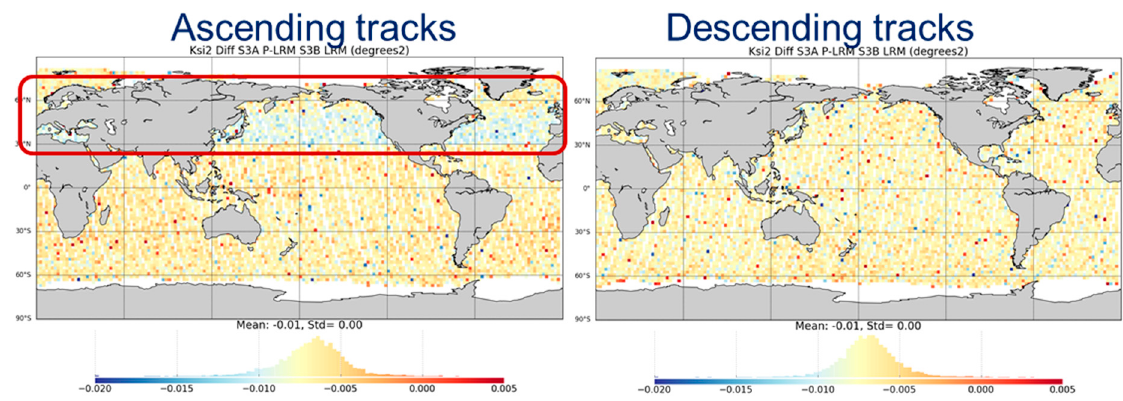
Figure 4. Mispointing angle differences between Sentinel-3 A and B for ascending ( left panel ) and descending passes ( right panel ).